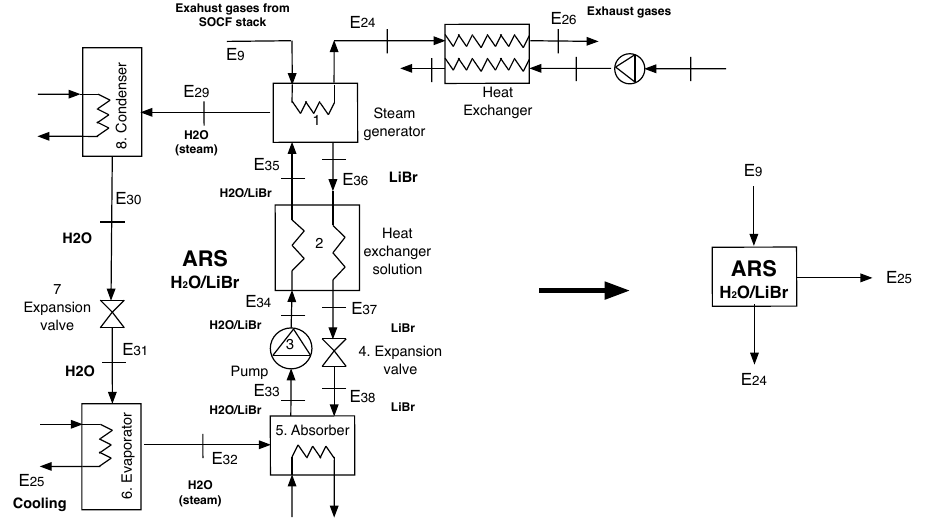
Figure 2. Schematic diagram of vapor-absorption refrigeration system: